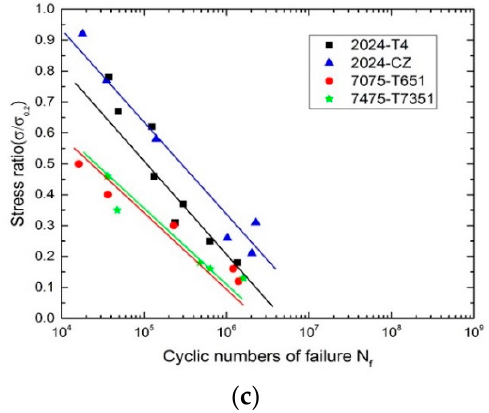
Figure 3. Effect of relative strength on the high ‐ cyclic fatigue performance of representative aluminum alloys in the different environmental media. ( a ) In the air case; ( b ) at 3.5 wt. % NaCl solution; ( c ) at 5.0 wt. % NaCl solution.